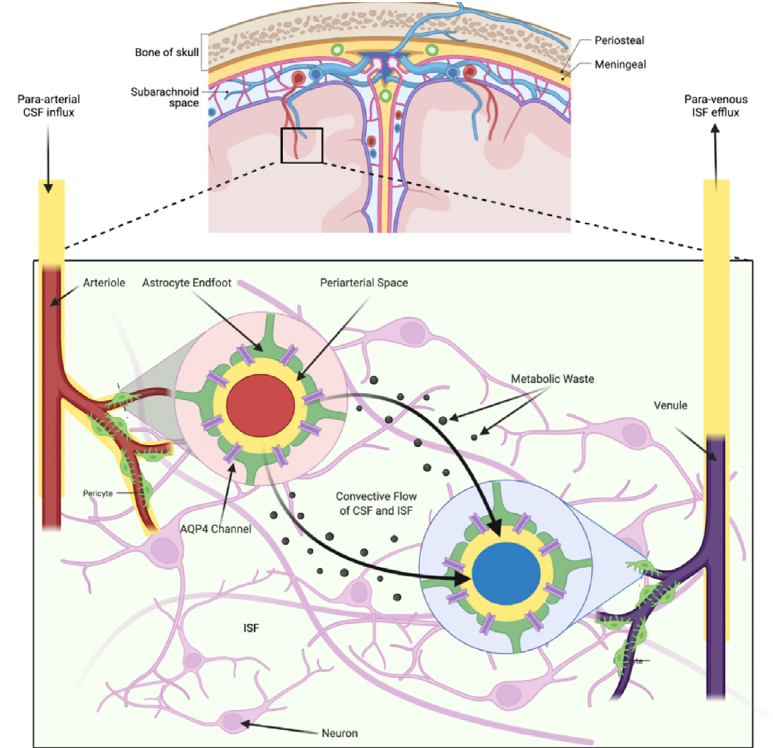
Figure 1. Overview of the circulation of CSF and ISF through the glymphatic pathway in brain